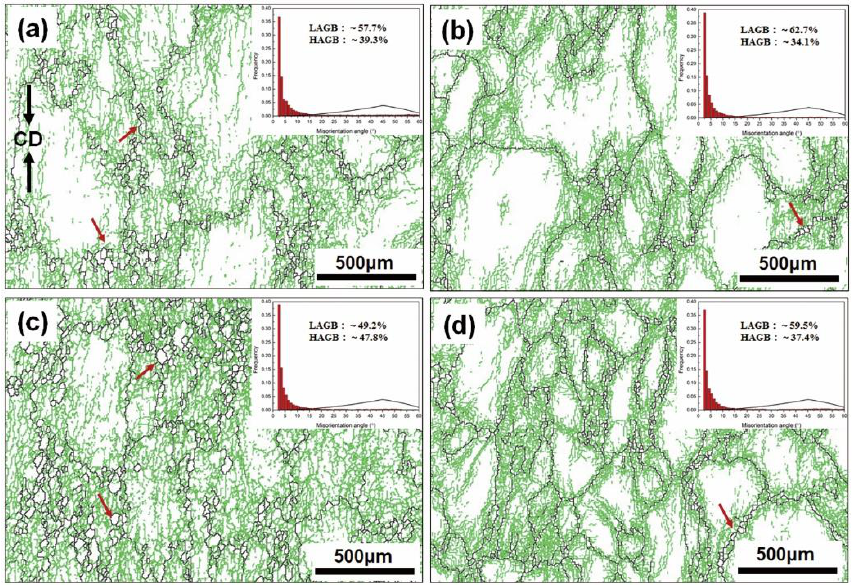
Figure 6. Grain boundary maps of the β phase at different deformation conditions: ( a ) 820 °C/0.001 s − 1 , ( b ) 820 °C/0.01 s − 1 , ( c ) 850 °C/0.001 s − 1 , ( d ) 880 °C/0.1 s − 1 . ( b ) 820 ◦ C/0.01 s − 1 , ( c ) 850 ◦ C/0.001 s − 1 , ( d ) 880 ◦ C/0.1 s − 1